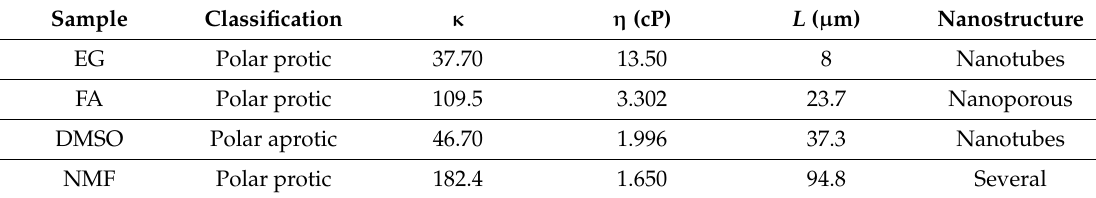
Table 2. Solvent characteristics: Classification at room temperature, dielectric constant ( κ ) and viscosity ( η ); AHO mean layer thickness L and the type of nanostructures obtained for the different samples.